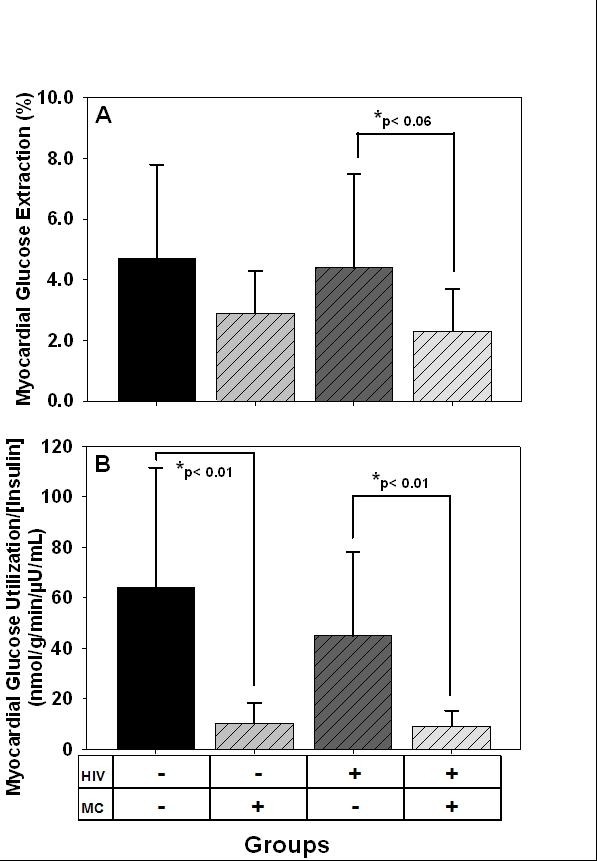
(A) Myocardial glucose extraction fraction (%), and (B) Myocardial glucose utilization normalized to plasma insulin concentration (nmol/g/min/μU/mL) in HIV+ and HIV-negative men with and without metabolic complications (MC).